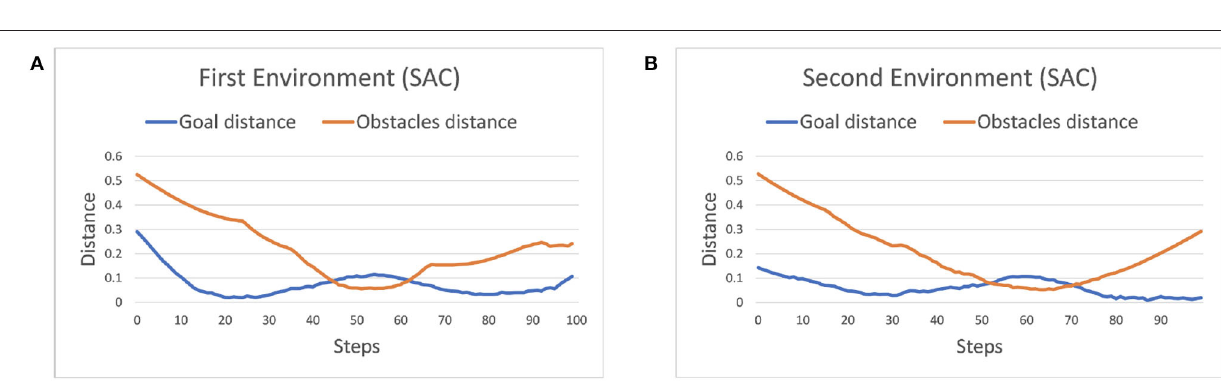
Frontiers in Neurorobotics |